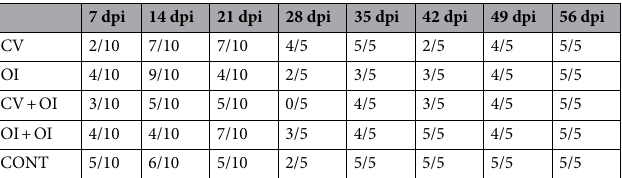
Table 1. Number of piglets shedding M. hyopneumoniae in nasal swabs collected from the 7th to the 56th day post-infection with the pathogen, detected by